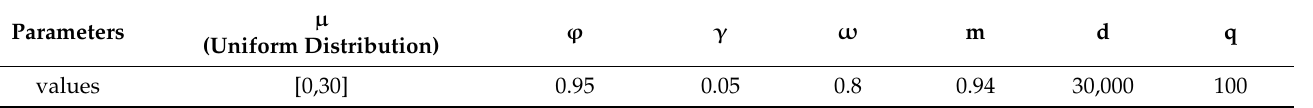
Table 1. ICAHP parameters for TSPTW-PWC.